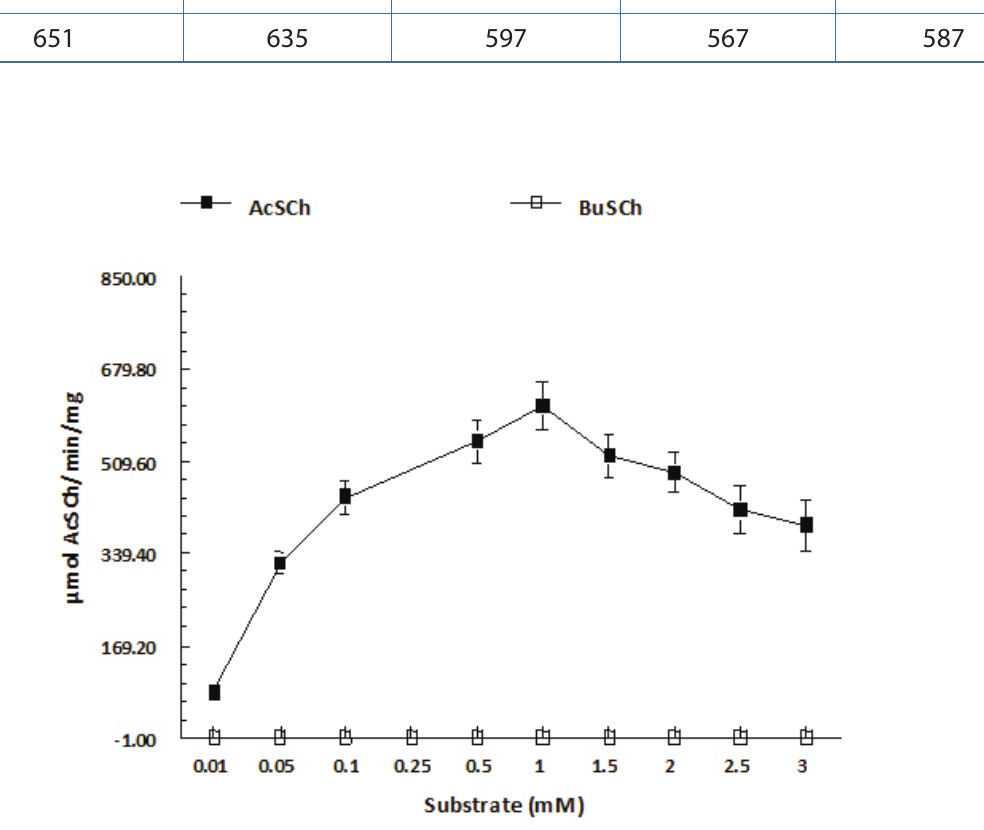
Figure 1. Substrate specificity. Hydrolysis of acetylthiocholine (AcSCh) and butyrylthiocholine (BuSCh) by krait ( Bungaraus sindanus ) venom AChE. Venom protein (1 µg) was preincubated for ten minutes in 1 mL buffer, pH 7.5, and 0.2 mM DTNB [5,5-dithiobis(2-nitrobenzoic acid)] before assay solutions with 10 mM PO 4 adding substrate at 0.05 to 3 mM. All experiments were repeated at least three times and similar results were